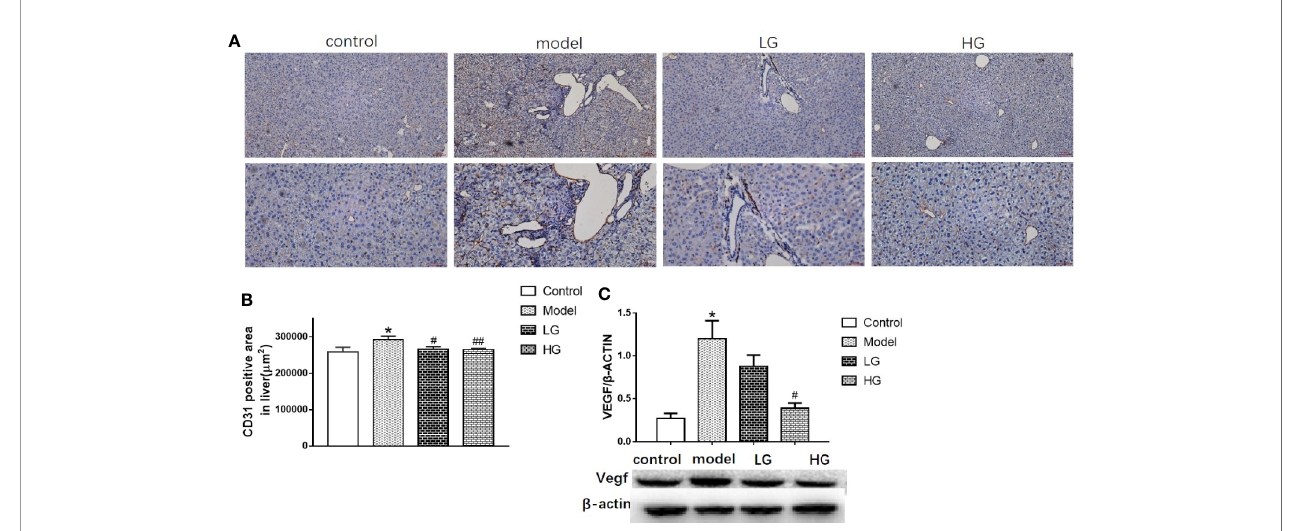
FIGURE 5 | Angiogenic ability of hepatocellular carcinoma in microenvironment is inhibited by GHJCD. (A) Representative image of CD31 immunohistochemical staining in liver tissue. Top scale bar: 200 µm; bottom scale bar: 100 µm. (B) Area of CD31-positive distribution in liver tissue (µm 2 ). (C) Expression of VEGF in liver tissue. CD31, VEGF data in the liver cancer microenvironment were analyzed by ANOVA. The homogeneity test was fi rst performed, P > 0.05, the variances were uniform, and the LSD (L) test was used for multiple comparisons afterward, P < 0.05, the variances were not uniform.*p < 0.05, **p < 0.01 vs. control; # p < 0.05 vs.